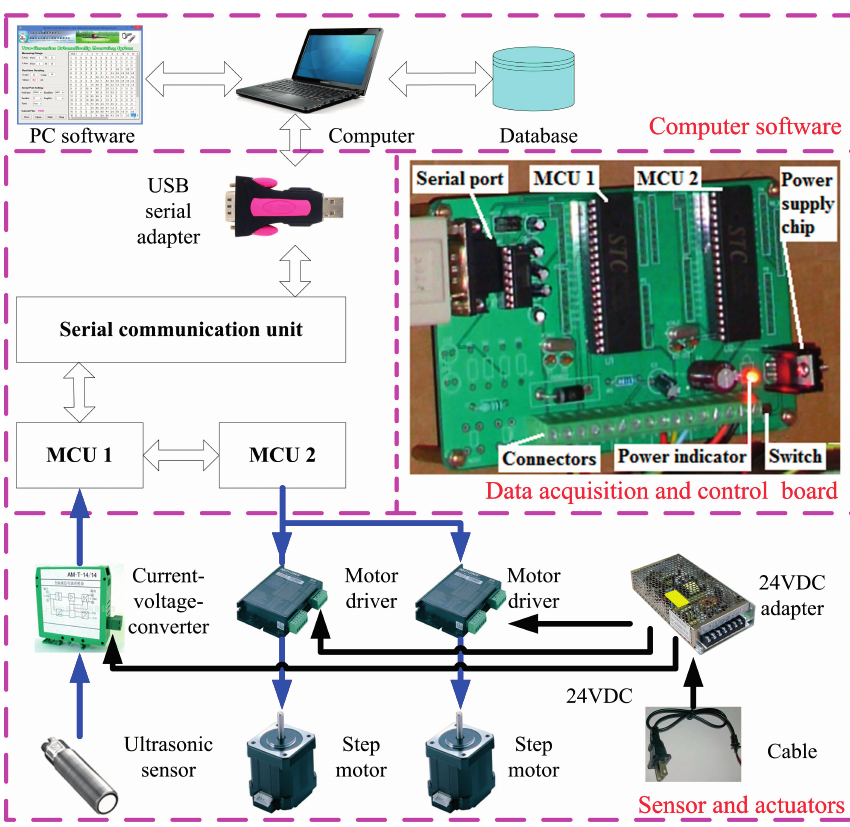
Figure 2. General block diagram of the system control